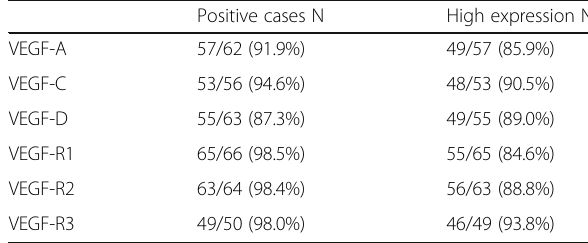
Table 3 Number of cases that expressed ( “ positive cases ” , 1+ to 3+) and those with “ high expression ” (> 25%, 2+ or 3+) for each VEGF subunit and cognate receptor